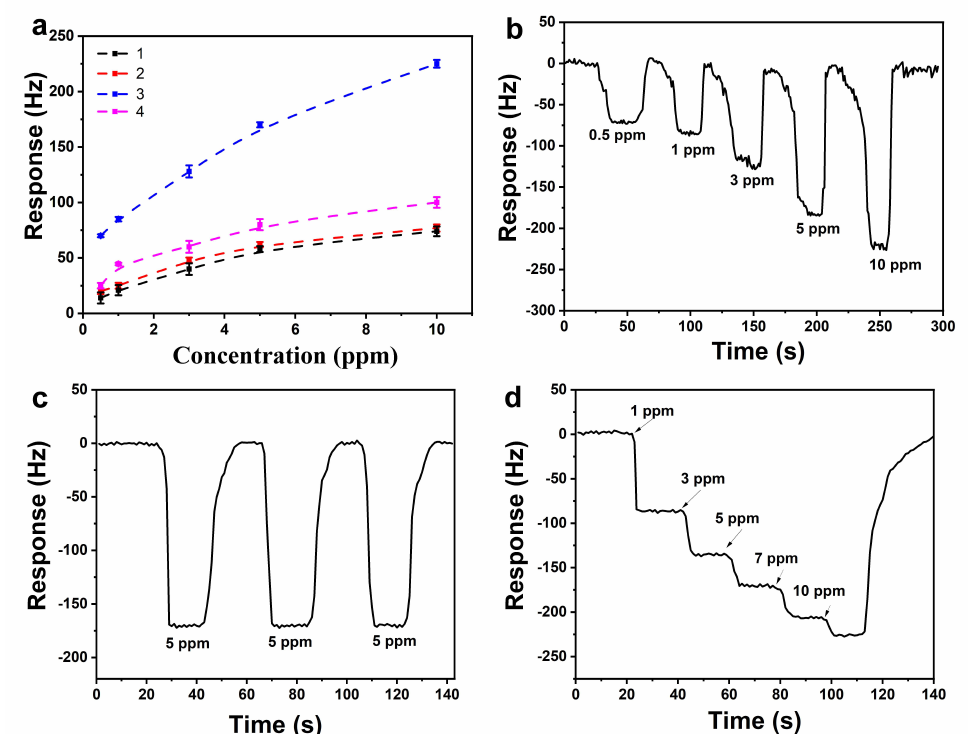
Figure 10. ( a ) The frequency responses of x-PANI-CNCS (x = 1, 2, 3 and 4) with 0.5–10 ppm formalde- hyde gas, ( b ) response of the PANI-CNC-based QCM sensors to HCHO at different concentrations in the range of 0.5–10 ppm, ( c ) cycling stability of PANI-CNC-based QCM to 5 ppm HCHO vapor, ( d ) dynamic responses of PANI-CNC-based QCM to 1–10 ppm HCHO